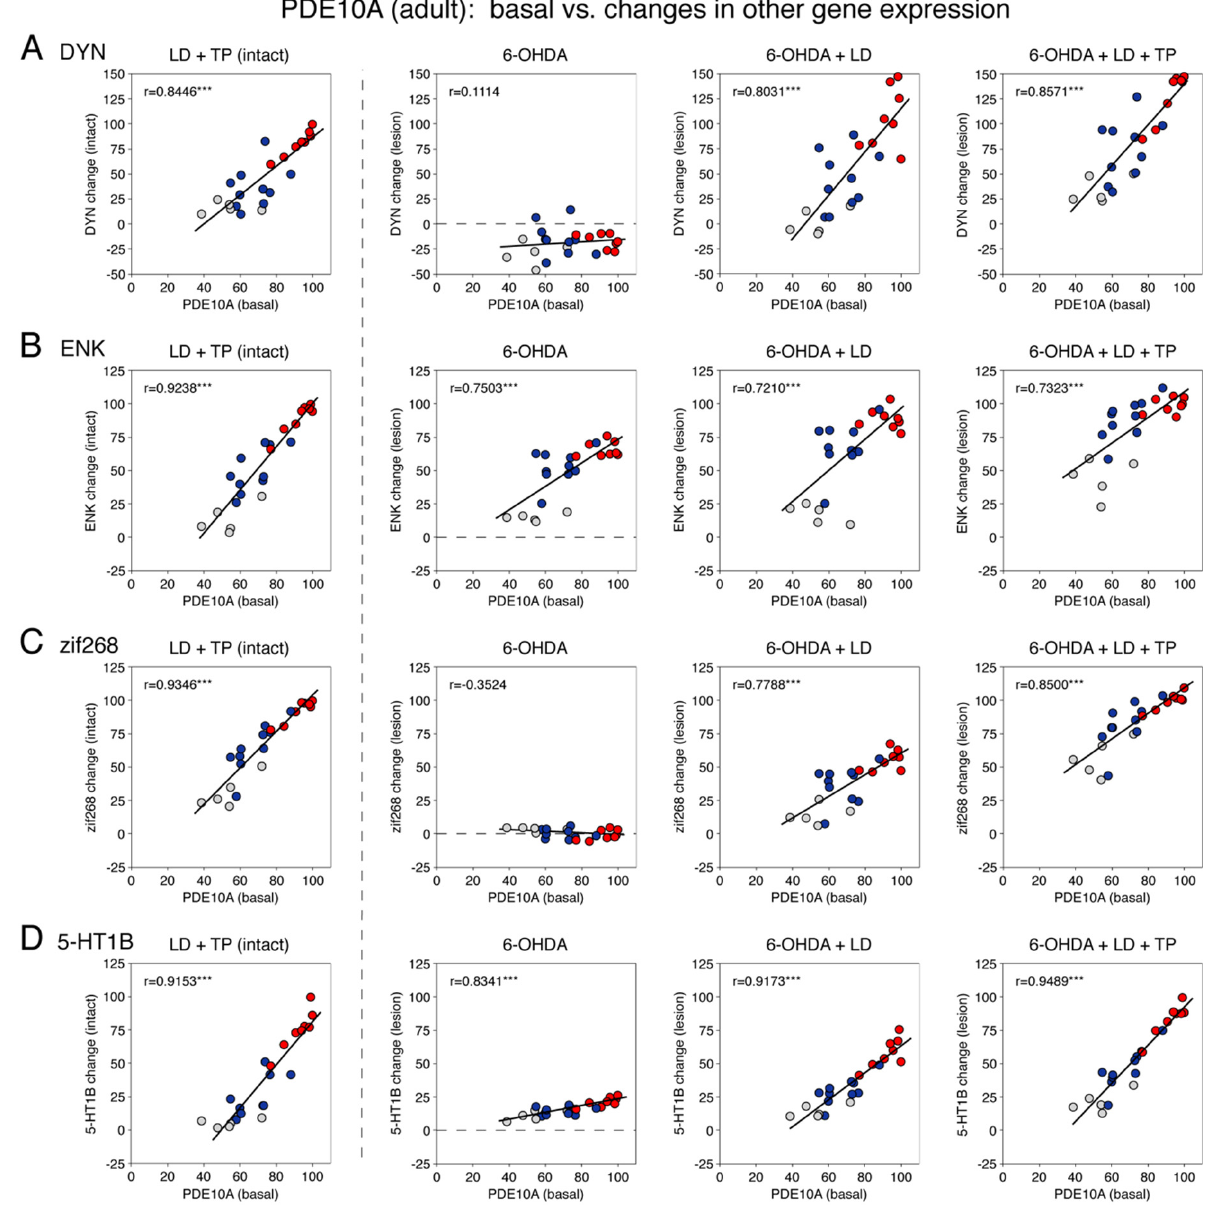
Figure 4. Relationship between basal expression of PDE10A and changes in the expression of dynorphin ( A ), enkephalin ( B ), zif268 ( C ) and 5-HT1B ( D ) after dopamine depletion and repeated treatment with L-DOPA and the PDE10A inhibitor TP-10 in adults. Scatter plots depict correlations between basal PDE10A expression (S/V, intact side; in % of max.) and changes in the expression of these genes after L-DOPA + TP-10 treatment (LD + TP group) on the intact side (left), changes after dopamine depletion only (6-OHDA; 6/V group, lesion side) (second from left), changes after dopamine depletion plus L-DOPA treatment (6-OHDA + LD; 6/LD group, lesion side) (second from right) and changes after dopamine depletion plus L-DOPA + TP-10 treatment (6-OHDA + LD + TP, 6/LD + TP group, lesion side) (right), all expressed as the percentage of maximal values on the intact side after L-DOPA + TP-10 treatment (LD + TP group; left) for the eight sensorimotor sectors (red dots), the ten associative sectors (blue dots) and the five limbic sectors (gray dots). *** p < 0.001.